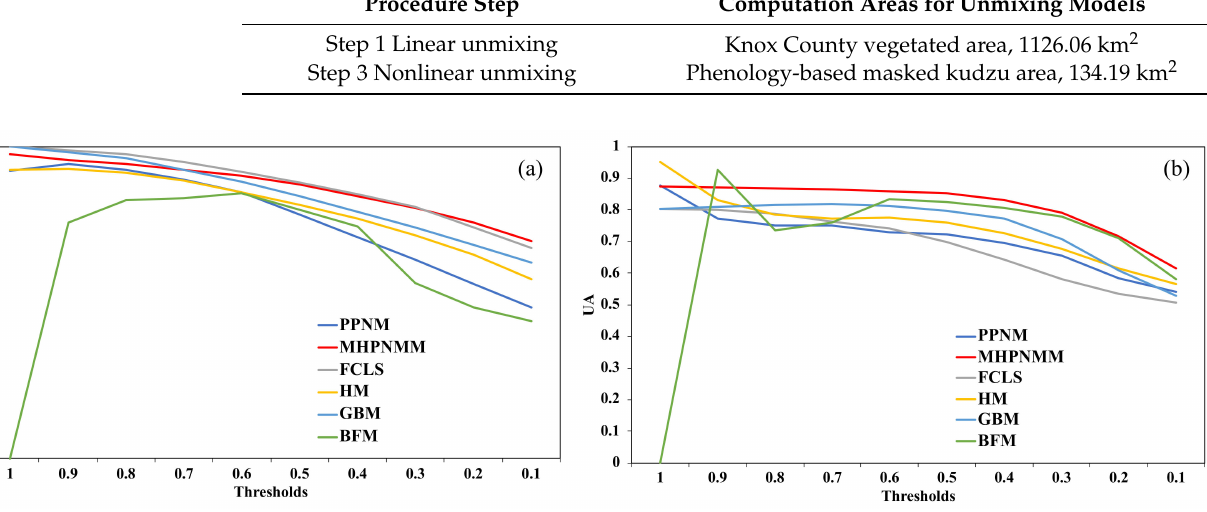
Figure 6. Kudzu classification performance at different thresholds for nonlinear unmixing models: ( a ) PA; ( b ) UA. Table 5 lists the classification accuracy indices based on the nonlinear model, MHP- NMM. Both PA and UA values are higher than 0.8 and the Jaccard values are higher than 0.7 at thresholds ≥ 0.4, suggesting that both commission and omission errors are